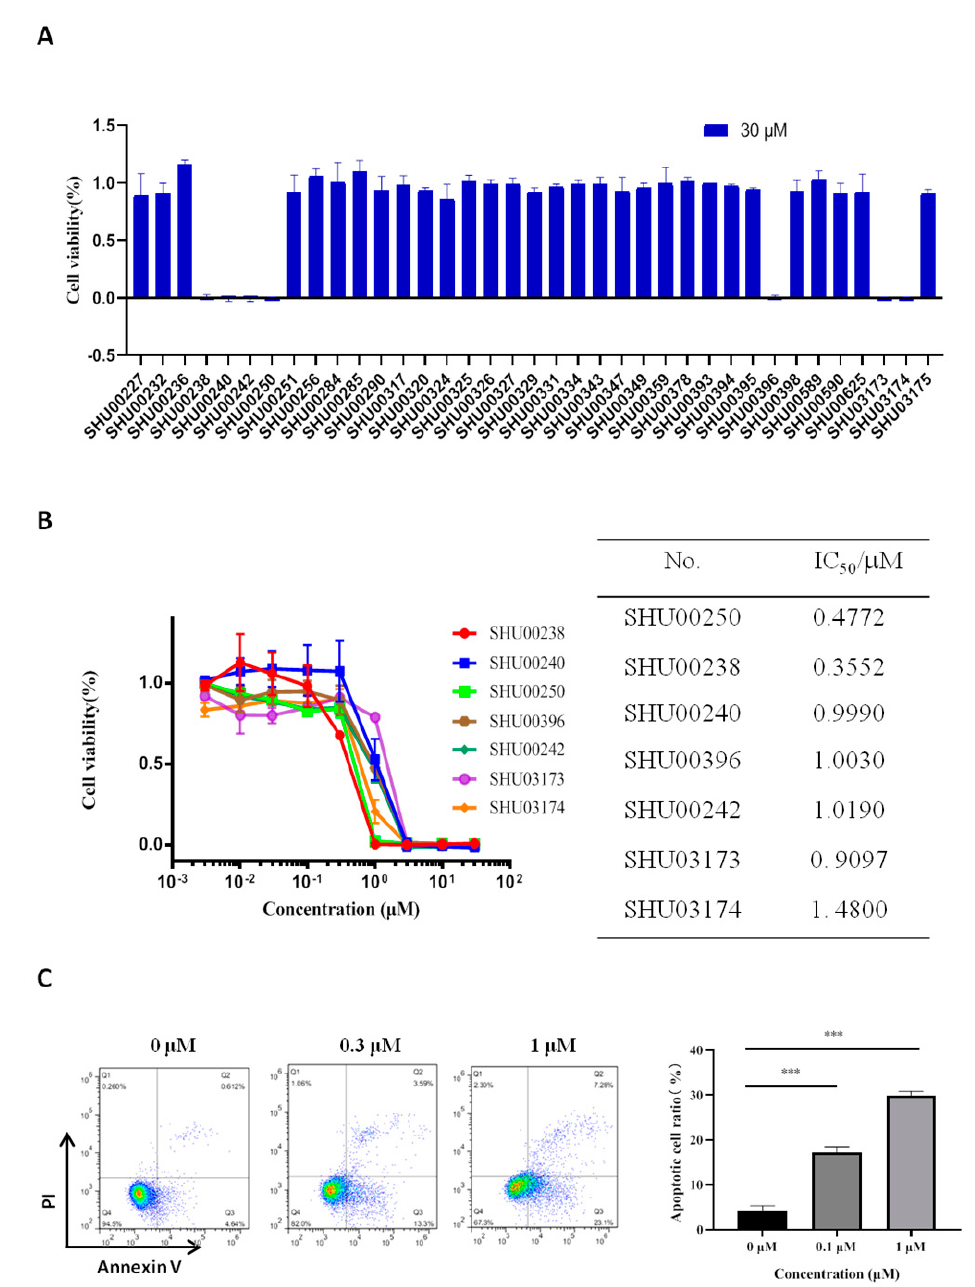
Figure 2. Seven compounds of 37 isoxazole derivatives suppress cell viability. ( A ) Cell viability analysis of HT116 cells treated with 30 μ M isoxazole derivatives, as determined by CCK-8 assay. ( B ) The IC 50 value of seven effective compounds in HCT116 cells, as determined by CCK-8 assay. ( C ) Apoptosis analysis of HCT116 cells treated with 0.3 μ M, 1 μ M SHU00238 (48 h, n = 3). ***, p < 0.001.